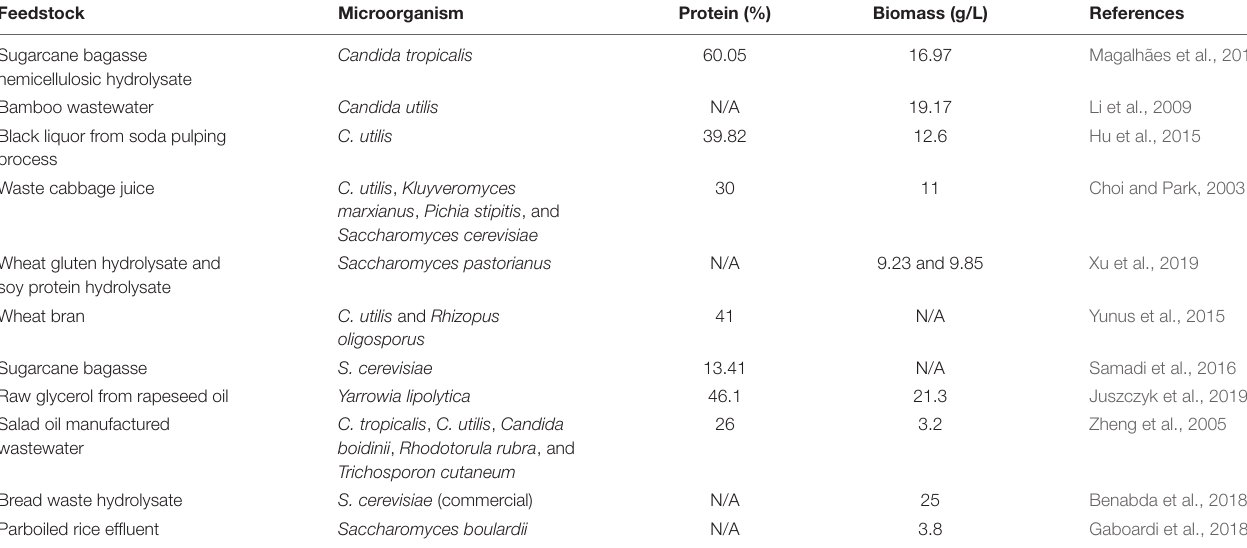
TABLE 2 | Agroindustrial byproducts and wastes used as feedstocks for single-cell protein from yeasts and the obtained maximum protein (%) and maximum cell biomass (g/L).